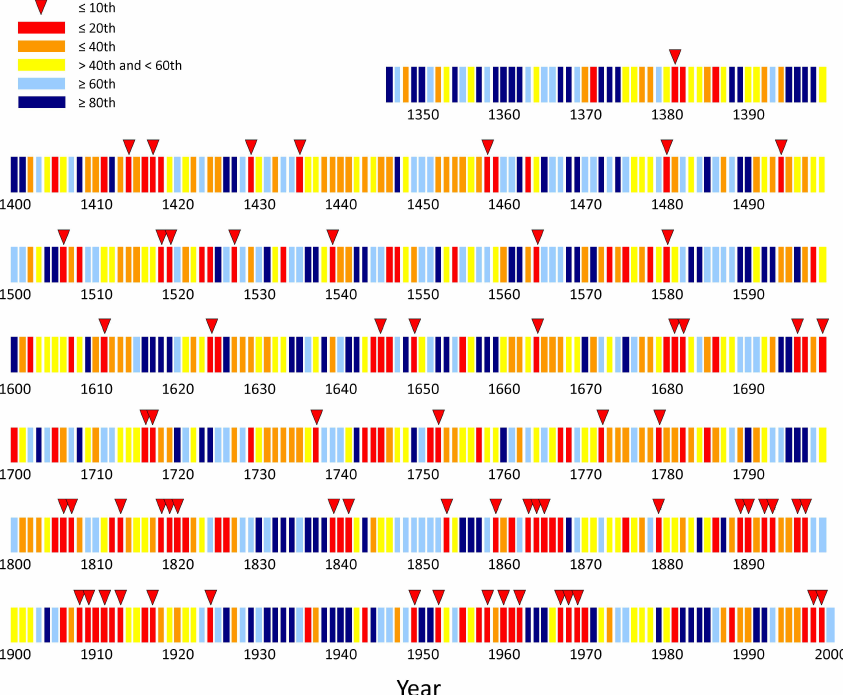
Fig. 5. Reconstructed Neuqu´en River streamflow values categorized by percentile. Values are shading-coded according to percentiles of flow. The years with triangles are the driest 10% of flows.